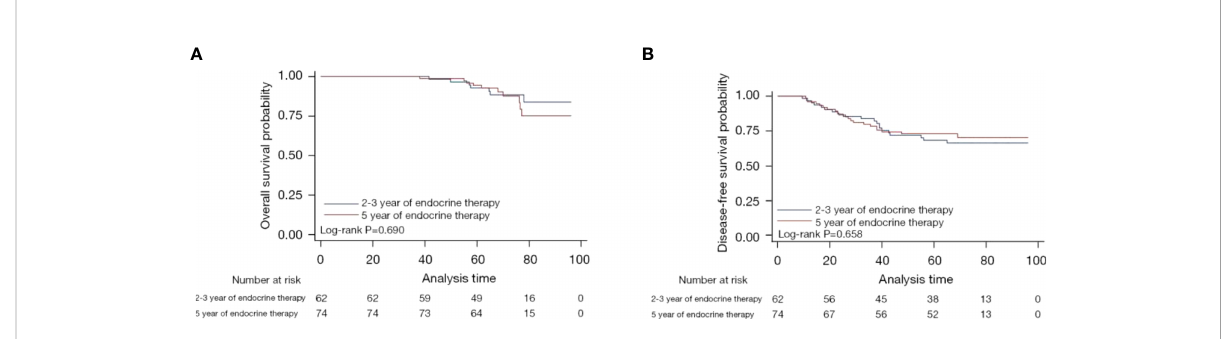
FIGURE 2 Kaplan-Meier curves for overall survival (A) and disease-free survival (B) of patients who received talazoparib versus